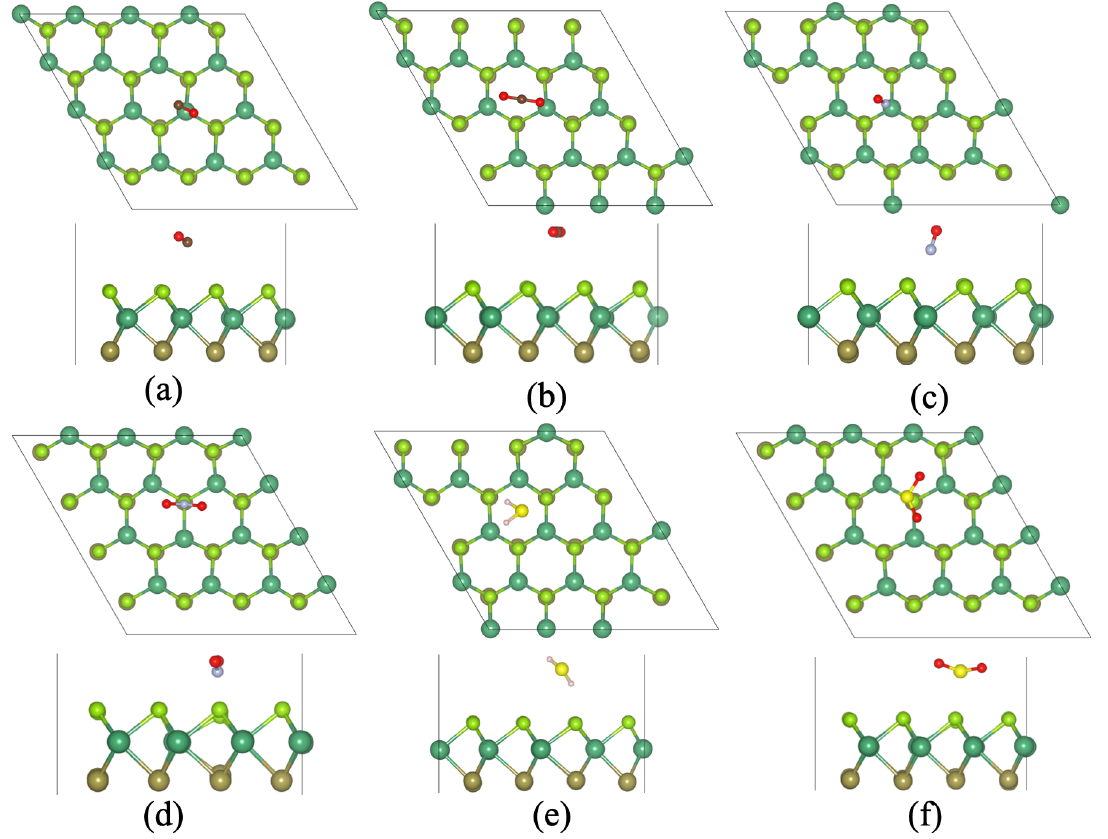
Figure 2. Optimized structure of toxic gas molecules adsorbed on the surface of the Janus NbSeTe monolayer with the top and side view. ( a ) CO, ( b ) CO 2 , ( c ) NO, ( d ) NO 2 , ( e ) H 2 S, and ( f ) SO 2 gas molecules adsorbed on Se-side of the Janus NbSeTe